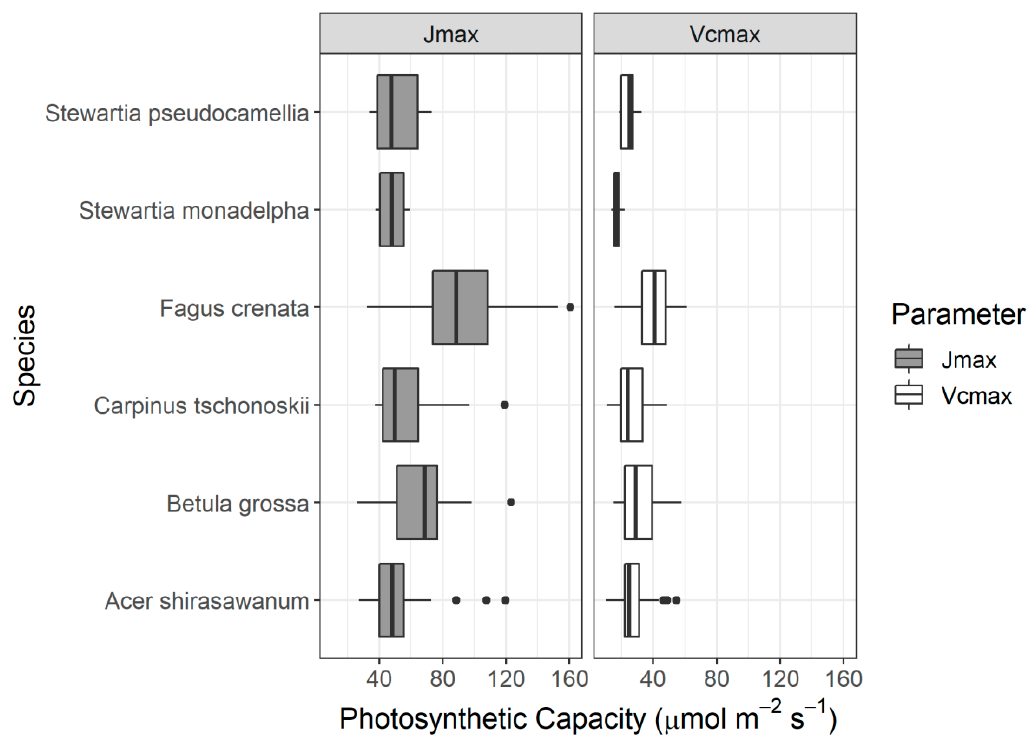
Figure 3. Variation of photosynthetic capacity from each species. Boxes show 25% and 75% quartiles, while the thick center line represents the median. Dots represent outliers.